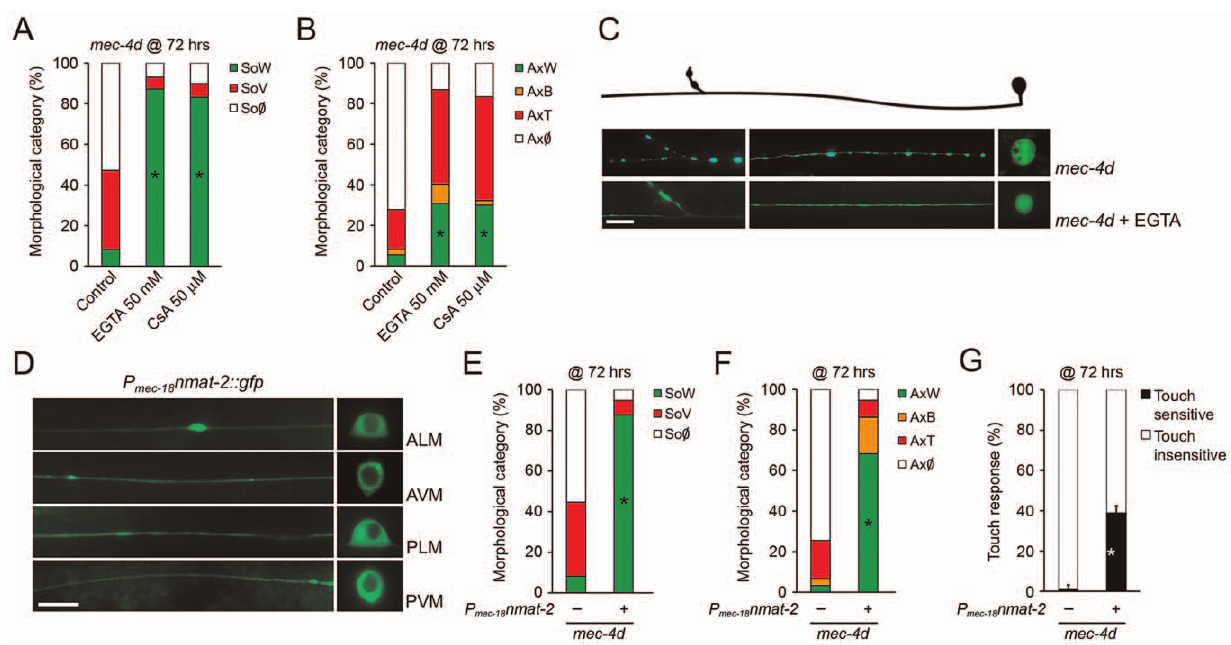
Figure 7. C.elegans and mammalian neurons share degenerative mechanisms triggered by diverse pro-degenerative stimuli. The mechanisms associated to somatic and axonal degeneration of AVM- mec-4d neurons were studied by pharmacological and genetic means. Worms were grown for 72 hours after hatching in food supplemented with EGTA (50 mM) or cyclosporin A (CsA, 50 m M). Both drugs delay degeneration of AVM somas (A) and axons (B) several fold (mean value for each category is shown; error bars [ , 1%] not included; N=3 of 30 worms each per group; *p , 0.01 by Student’s t test compared with control for the SoW and AxW category). (C) Fluorescent micrograph of a beaded axon (AxB) and a vacuolated soma (SoV) of a mec-4d -expressing AVM, contrasted with an AVM neuron treated with EGTA displaying a wild-type axon (AxW) and soma (SoW). Scale bar, 10 m m. (D) Touch neuron-specific expression of nmat-2::gfp ( P mec-18 nmat-2::gfp ), which is restricted to the cytosol in all TRNs. Scale bar, 10 m m. Overexpression of NMAT-2::GFP in TRN protects to a large extent somas (E) and axons (F) from mec-4d dependent degeneration at 72 hours post hatching (mean value for each category is shown; error bars [ , 0.1%] are not included; N=3 of 30 worms each per group; *p , 0.01 by Student’s t test compared with control for the SoW and AxW category). (G) Anterior touch response of worms at 72 hours post hatching. The almost complete functional impairment triggered by mec-4d is significantly rescued by NMAT-2::GFP overexpression (mean values are shown, error bars indicates SEM, N=3 of 30 worms each per group; p , 0.05 by Student’s t test for touch sensitivity